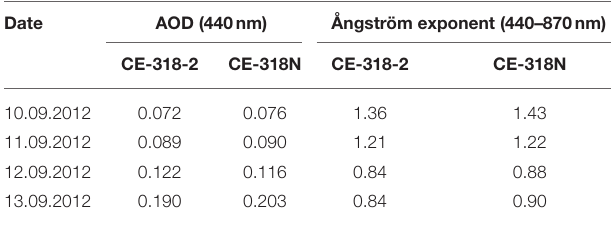
TABLE 2 | Results of Kyiv and Kyiv-AO sun-photometers